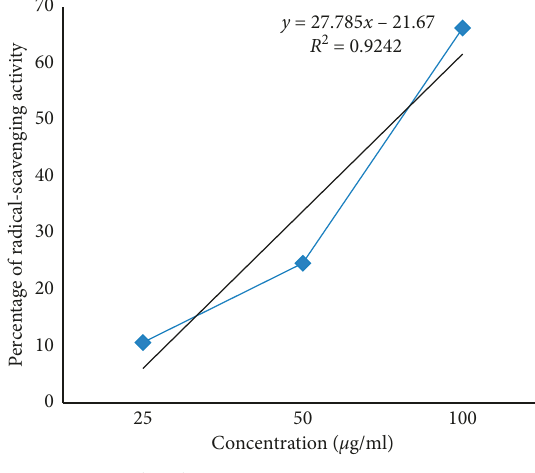
3) as a function of (cid:31)